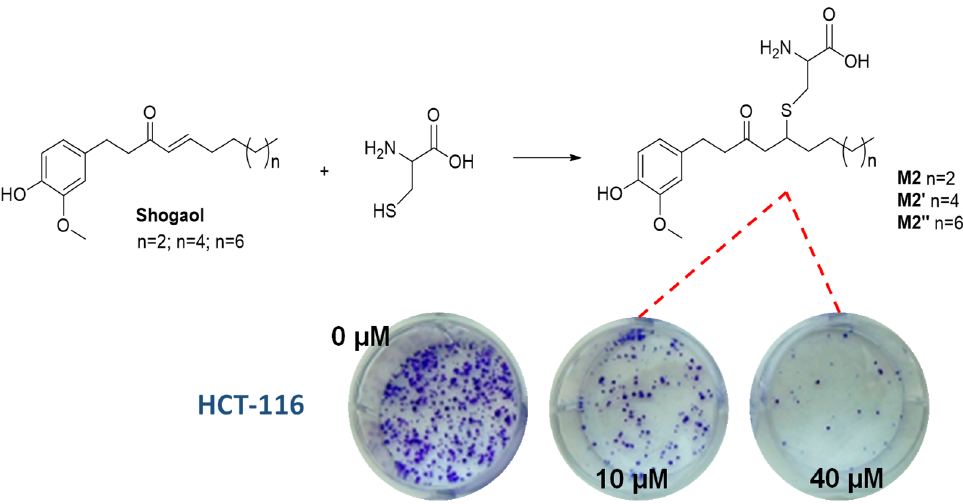
Figure 4. Schematic representation of shogaol conjugates formation (M2) and their ability to inhibit colony formation in human colon cancer cell (HCT-116) with doses ranging from 0 to 40 μM over 2 weeks.